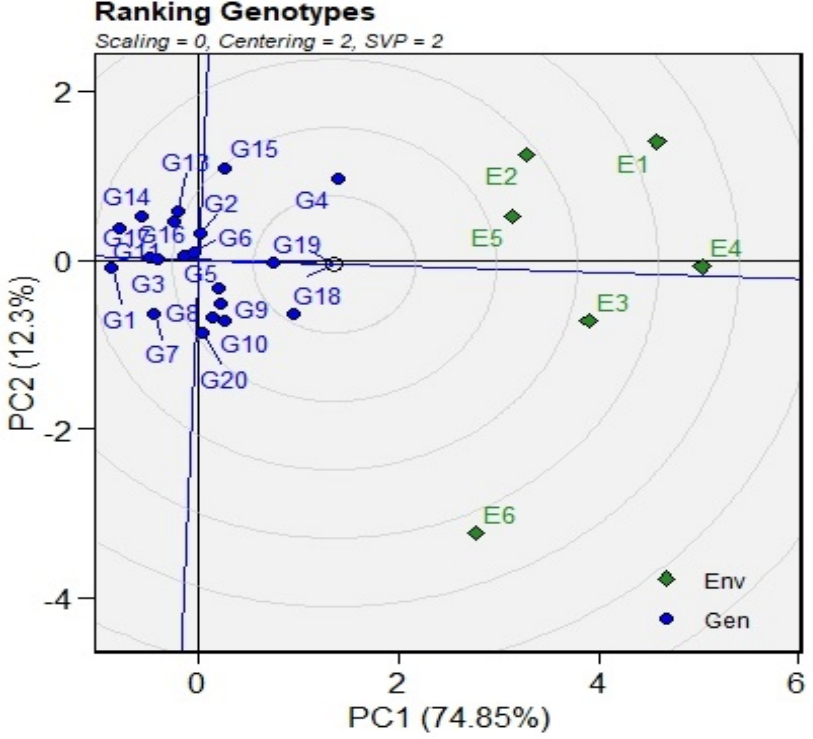
Figure 7. The discrimination and representativeness view of the GGE biplot for 20 wheat genotypes evaluated across six test environments. The genotype (G) code is indicated according to Table 6.